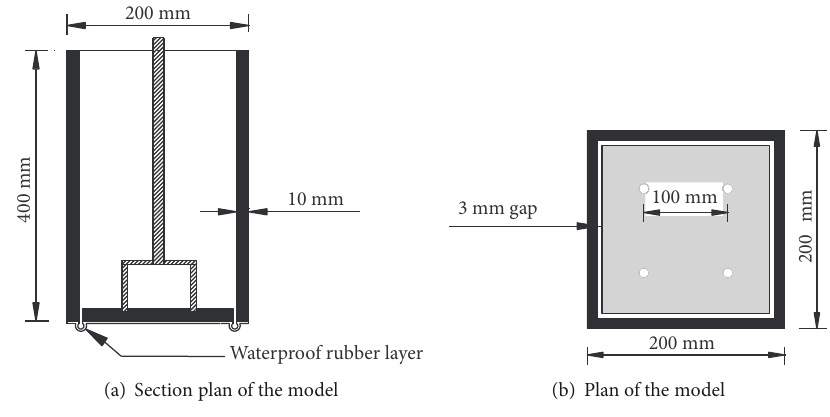
Figure 3: Model of the underground structure.